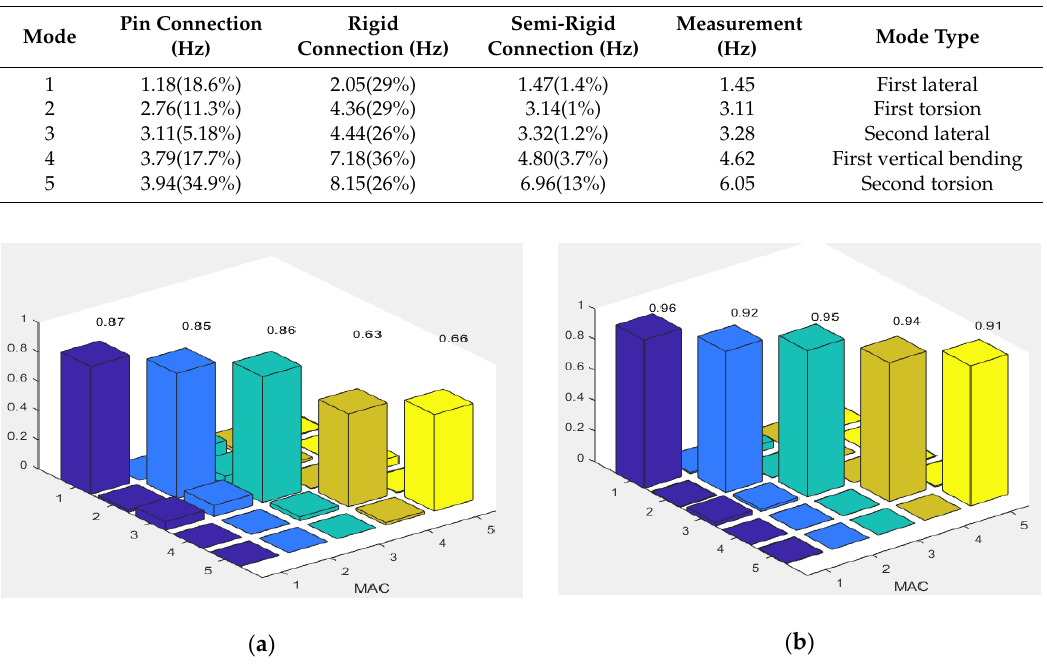
Figure 14. MAC values of mode shapes before model updating: ( a ) Rigid connection, ( b ) semi-rigid connection.